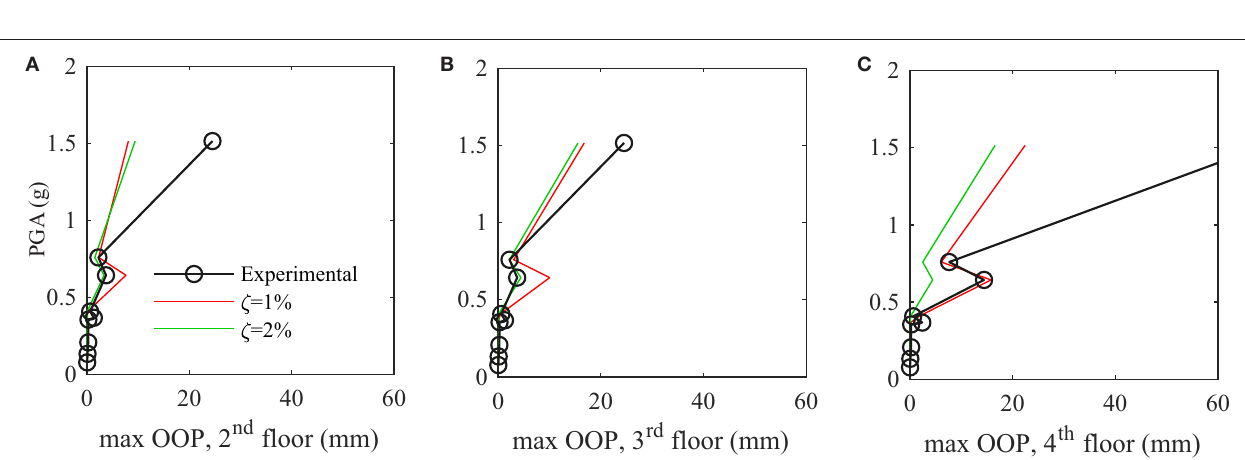
of maximum base shear forces, accelerations, and